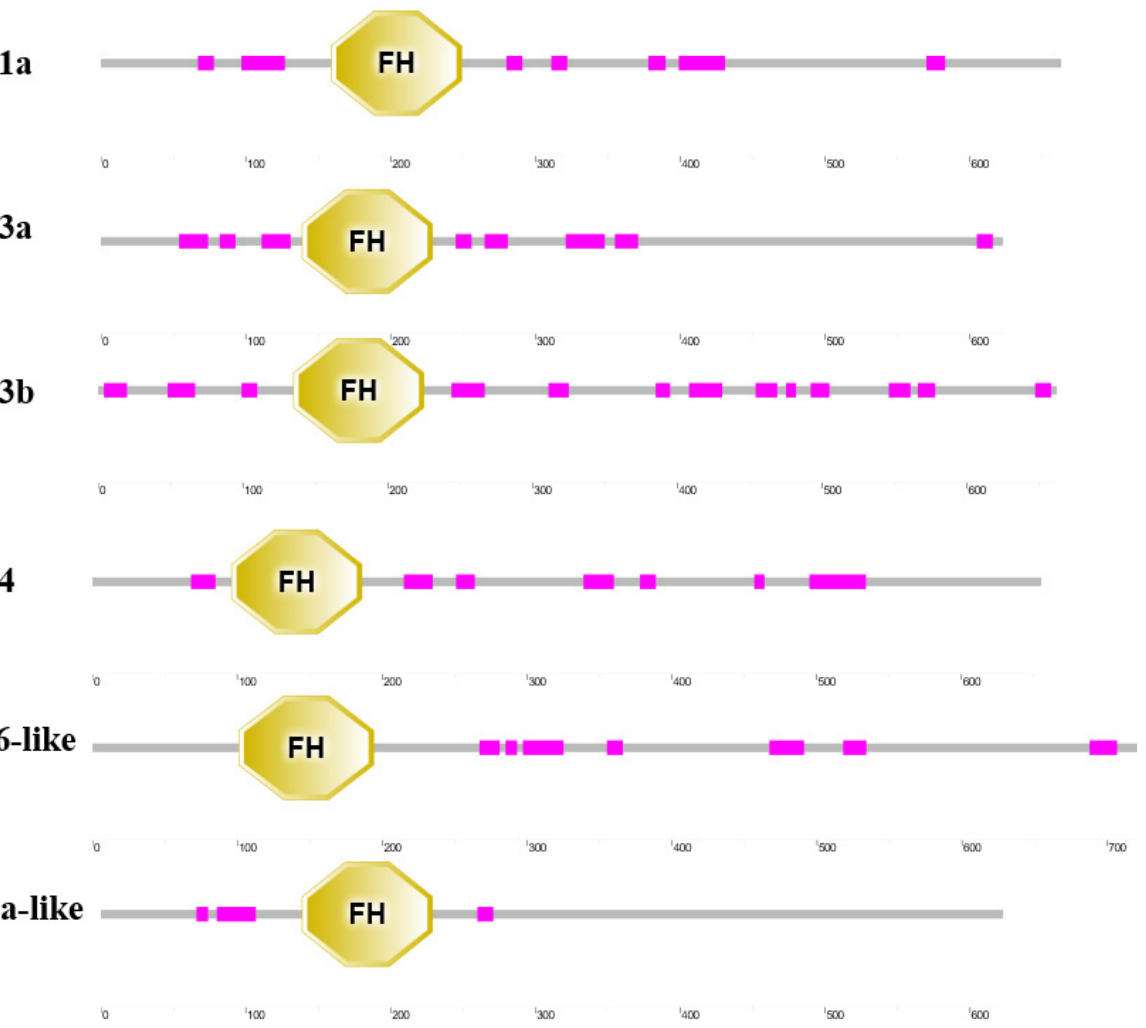
Figure 1. The conserved domain of the Csfoxo protein. Horizontal grey bars represent amino acid sequences with no predictive functional domains, while colored boxes represent regions with reliable predictive domains. Forkhead binding domain (yellow); Low-complexity region (pink).